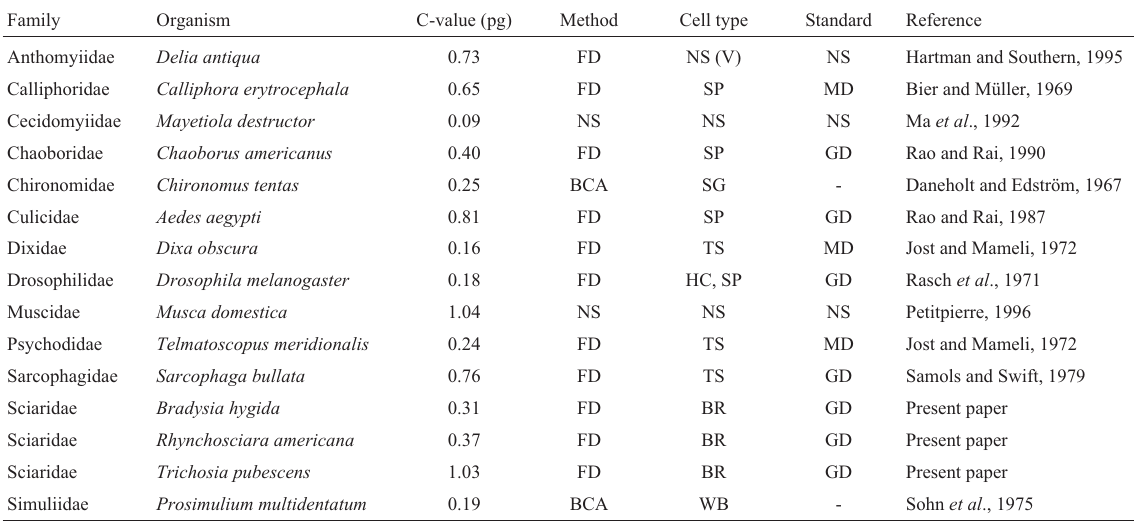
Table 2 - C-value of some representative Diptera